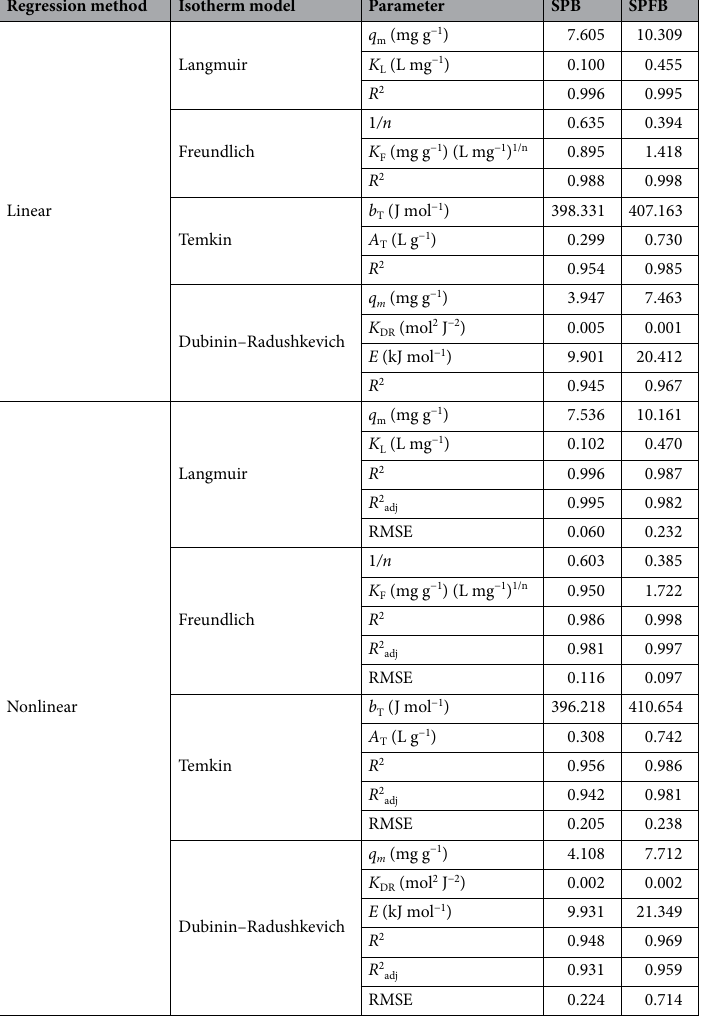
Table 5. The comparison of linear and nonlinear isotherm parameters for RB4 dye adsorptions on sawdust beads (SPB) and sawdust powder doped iron (III) oxide-hydroxide beads